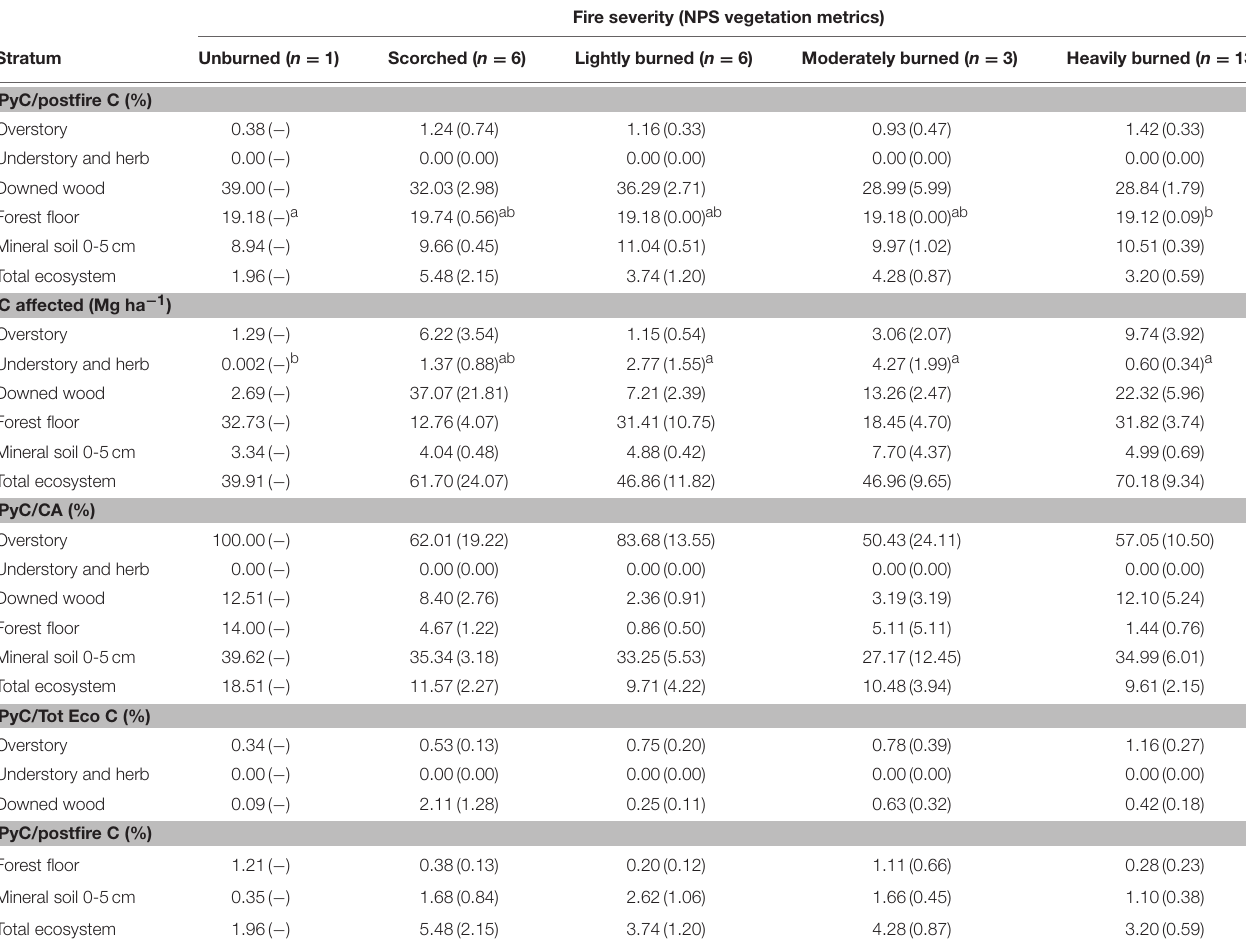
TABLE 4 | Post-fire PyC (estimated as PyC CTR via chemical oxidation) proportions of post-fire C, C affected, and post-fire total ecosystem C for plots measured before and after fire in mixed-conifer forest type. Fire severity (NPS vegetation